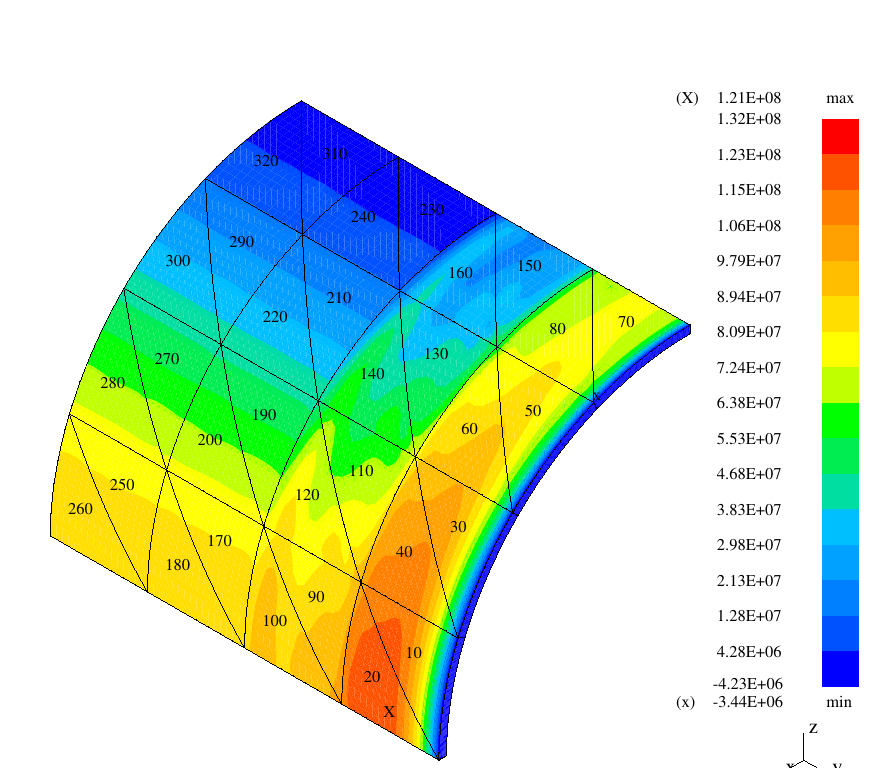
Figure 18. Third normal stress—the membrane with the classical transition elements.